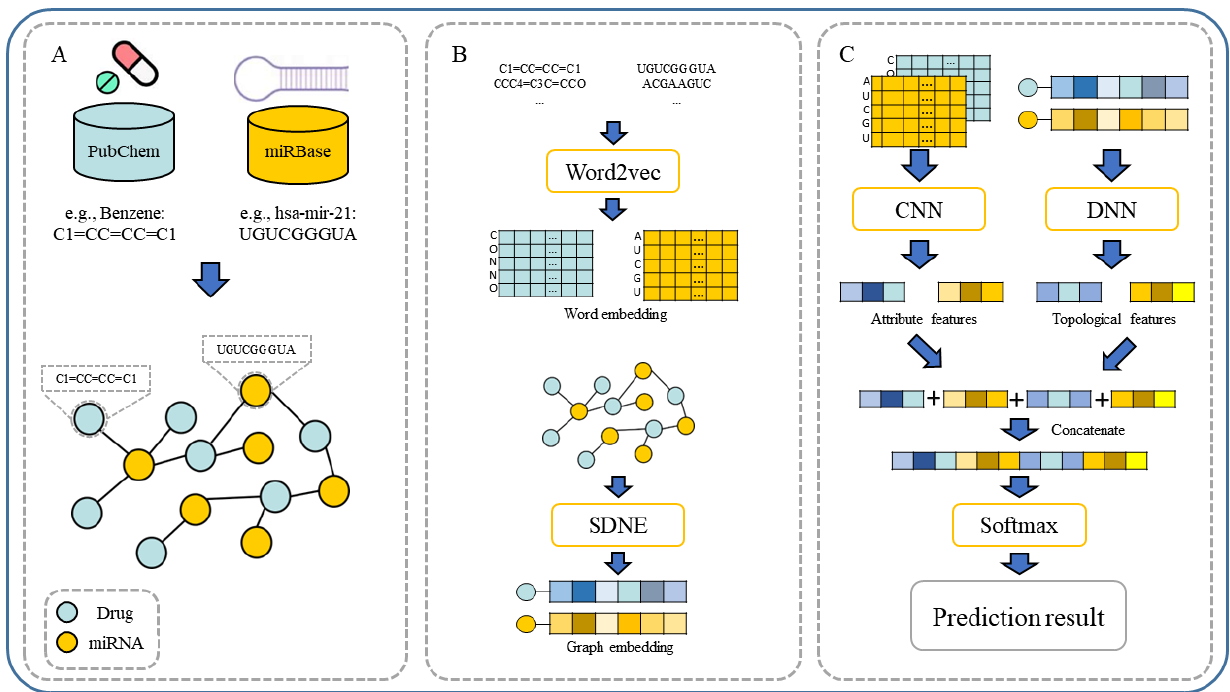
Figure 1. The flowchart of the proposed model. ( A ). Construction of drug–miRNA association network. ( B ). The workflow of word embedding and graph embedding. ( C ). The workflow of feature fusion and prediction.